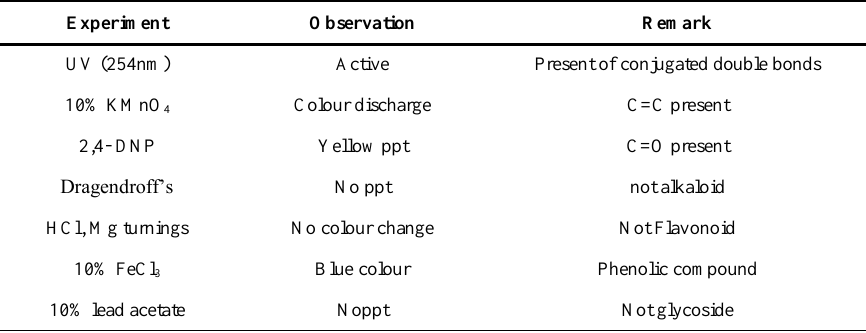
Table 10. Physico-chemical Properties of Isolated